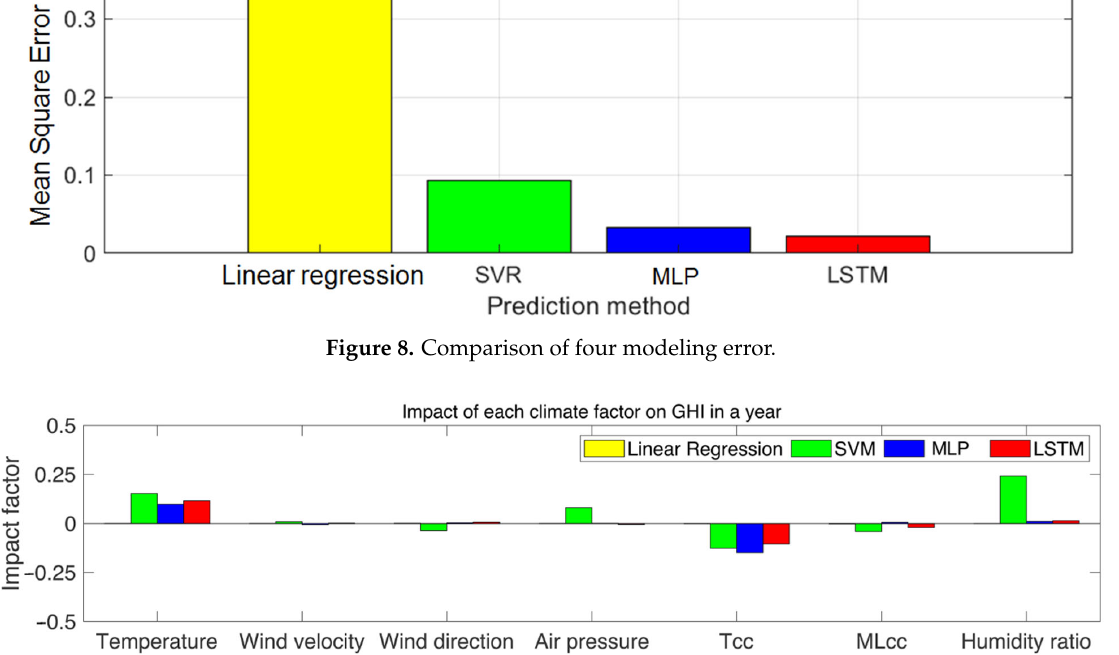
Figure 8. Comparison of four modeling error.